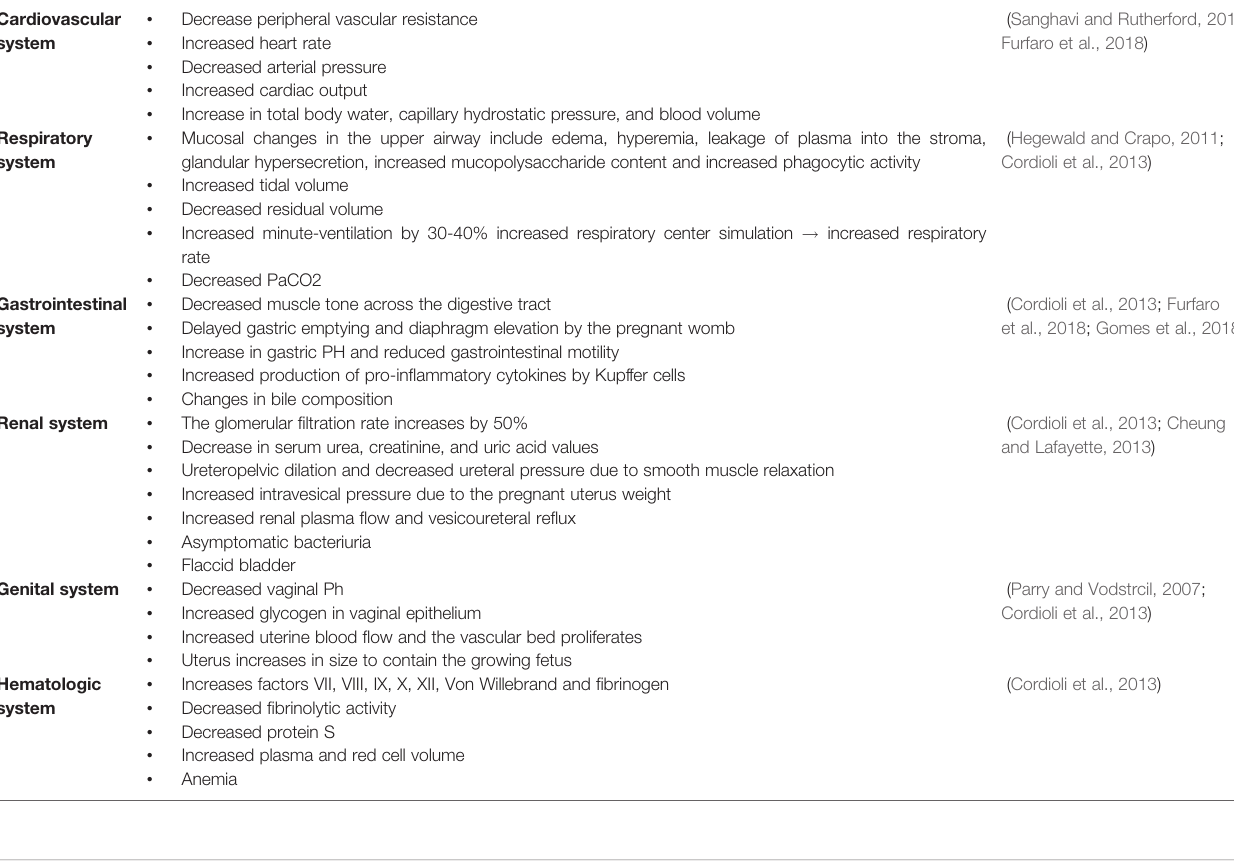
TABLE 1 | Physiological changes during pregnancy.